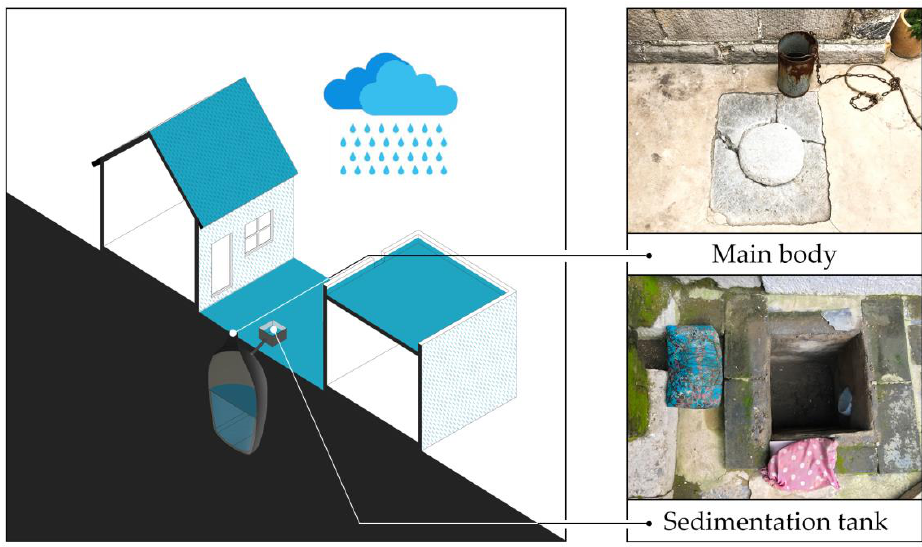
Figure 1. Rainwater harvesting system of water cellars and photos of their